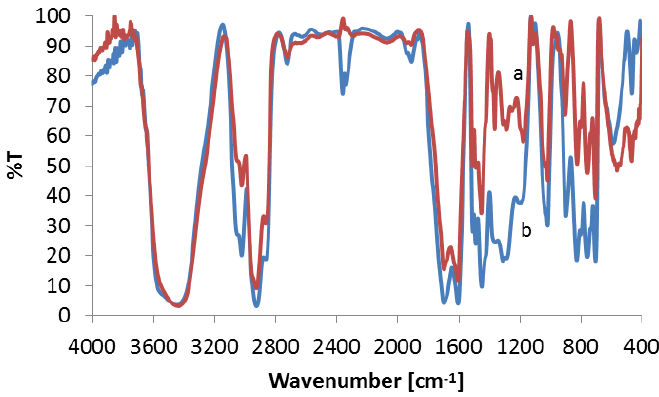
Figure 5. FTIR spectra of Purolite MN 202 (a) and Purolite MN 202 impregnated with Cyanex 272